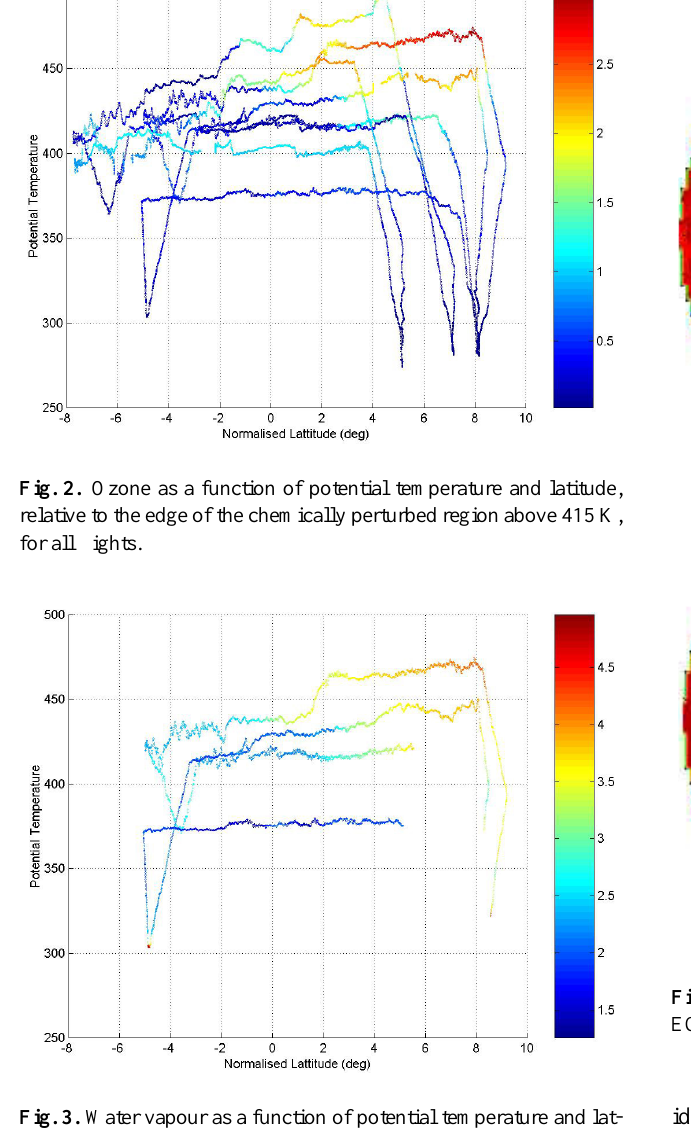
Fig. 3. Water vapour as a function of potential temperature and lat- itude, relative to the edge of the chemically perturbed region above 415 K, for all flights.